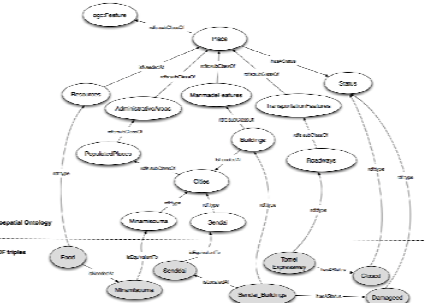
Figure 5. Mapping RDF triples to OGC geospatial ontology